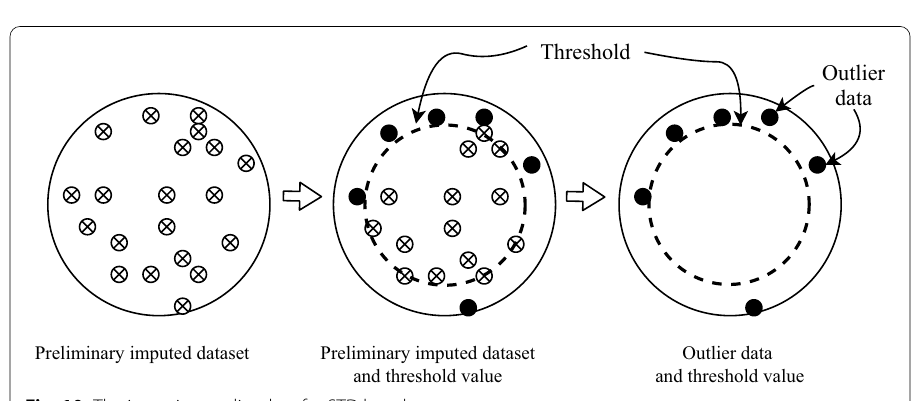
Fig. 10 The imputing outlier data for STD less than one